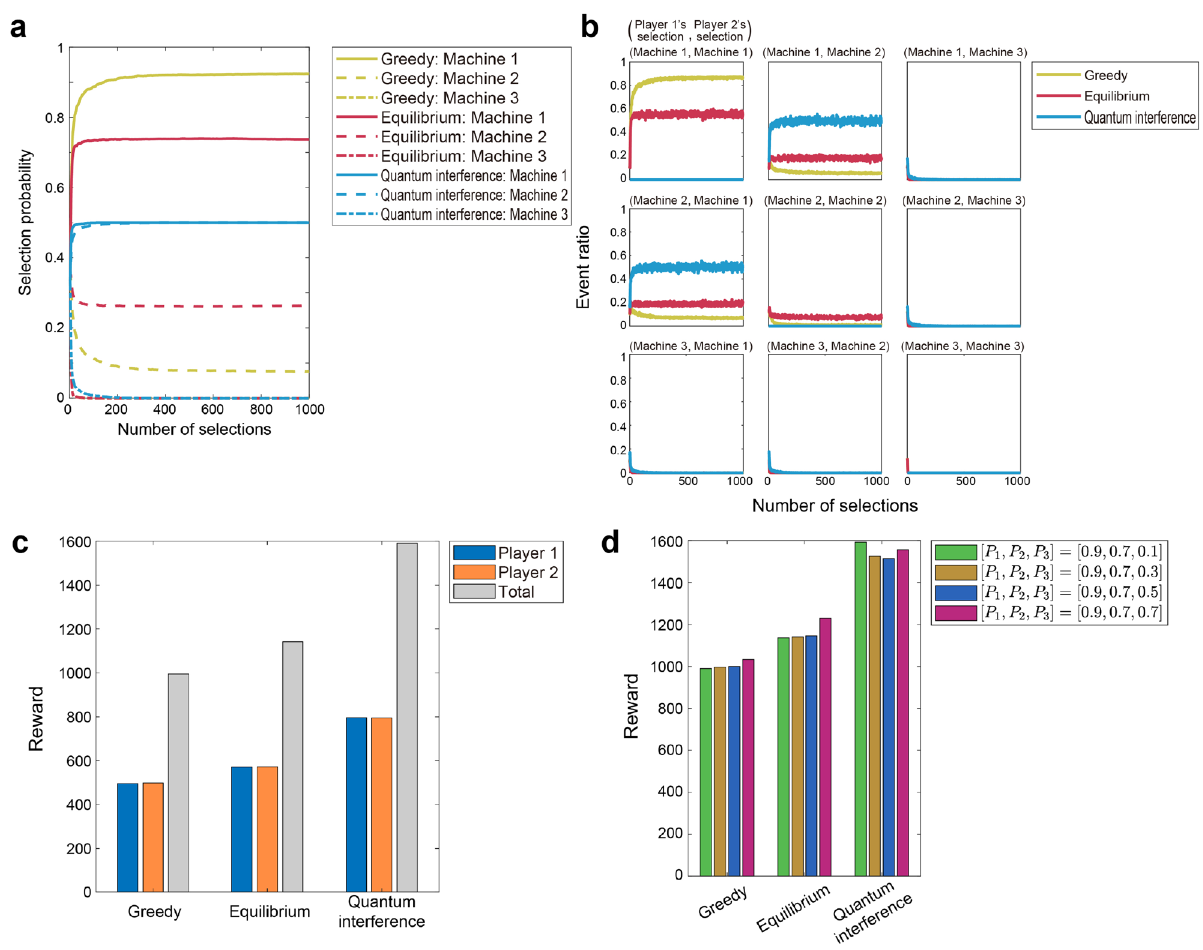
Figure 7. Simulation results for solving 2-player 3-armed competitive bandit problem with greedy, equilibrium and quantum interference policies. (a) Probability of selecting each machine over 1000 selections when P P P 0.9, 0.7, 0.1 averaged over 1000 repetitions. (b) Ratio of each selection pair over 1000 selections 1 , 2 , 3 [ ] = [ ] and 1000 repetitions. (c) Average rewards of player 1, player 2, and total rewards over 1000 selections with P P P 0.9, 0.7, 0.1 averaged over 1000 repetitions. (d) Average total rewards with different reward 1 , 2 , 3 [ ] = [ ] probability over 1000 selections and 5000